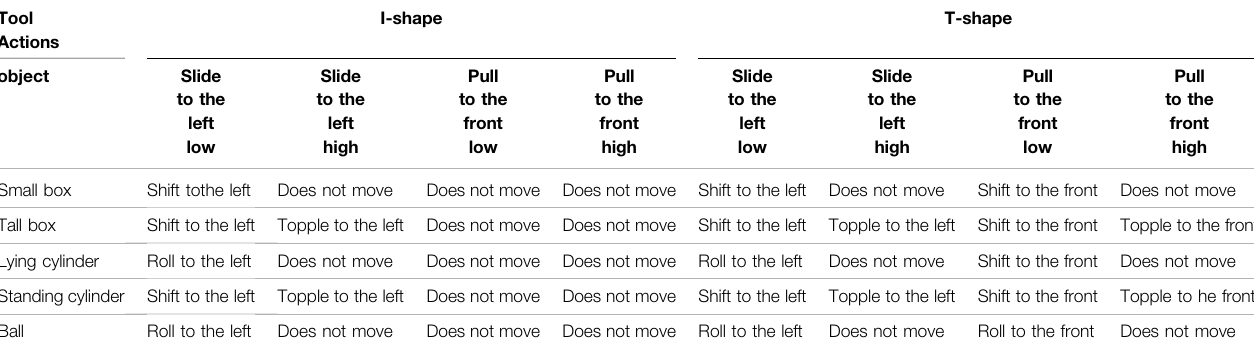
TABLE 3 | Forty dataset combinations for training whose sensorimotor data is recorded in advance by remote controlling the robot. Effects are roughly categorized and colored differently. We allowed the robot to experience these combinations of tools, objects, actions, and effects for training the tool-use model. Tool